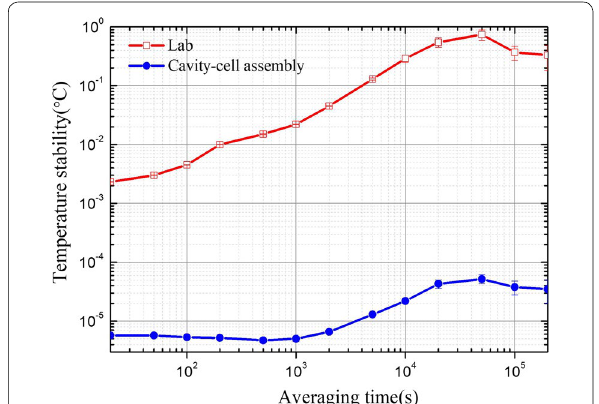
Fig. 7 Hadamard deviations of the cavity-cell assembly and laboratory